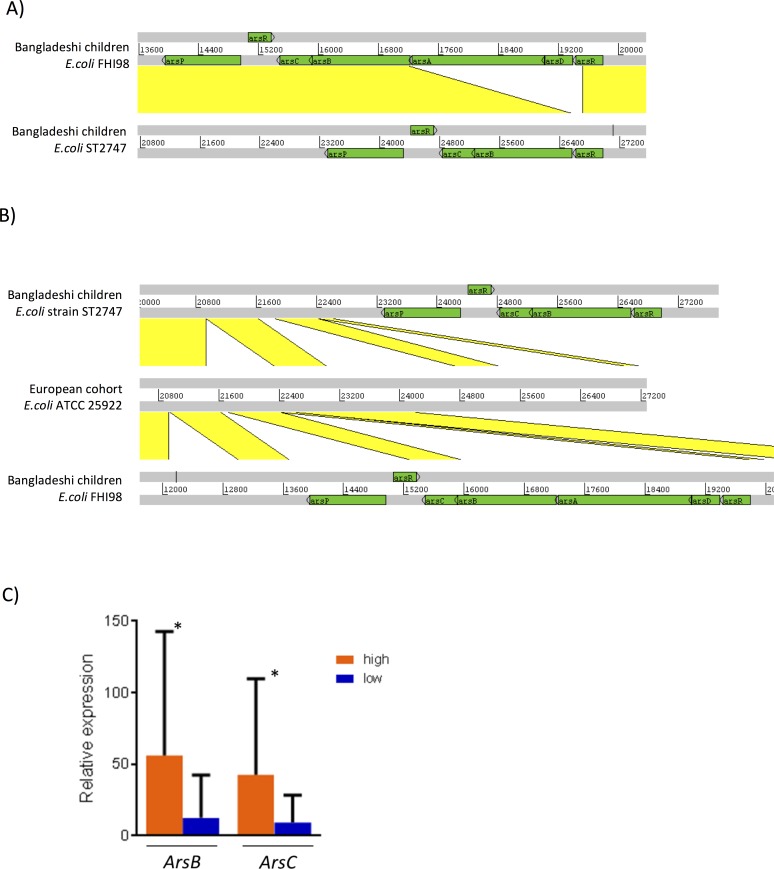
A) Comparison (displayed using Artemis Comparison Tool; doi 10.1093/bioinformatics/bti553) of DNA sequences of E.coli strains in Bangladeshi children cohort. Gray bars represent the forward and reverse strands of DNA. The yellow lines between the sequences represent existence nucleotide similarity (blastn). Arsenic resistant operons are given green color. B) Comparison of DNA sequences of E.coli strains in Bangladeshi children and European cohort. Comparison is displayed for two E.coli strains in Bangladesh children (ST2747 and FHI98) and their most similar E.coli strain in European cohort (ATCC 25922). C) qPCR quantification of two arsenic resistance operon genes (ArsB, ArsC) found in Bangladeshi children E.coli strain ST2747. (* p value<0.05).